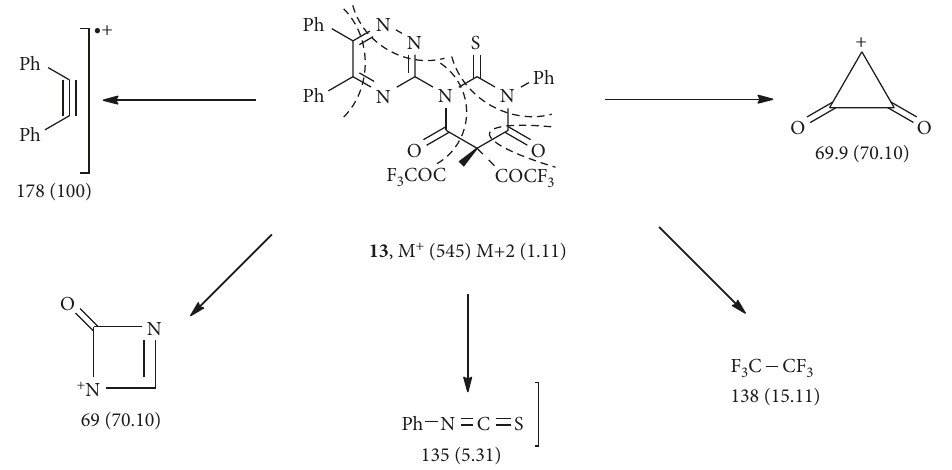
Figure 2: Mass fragmentation pattern of compound 13